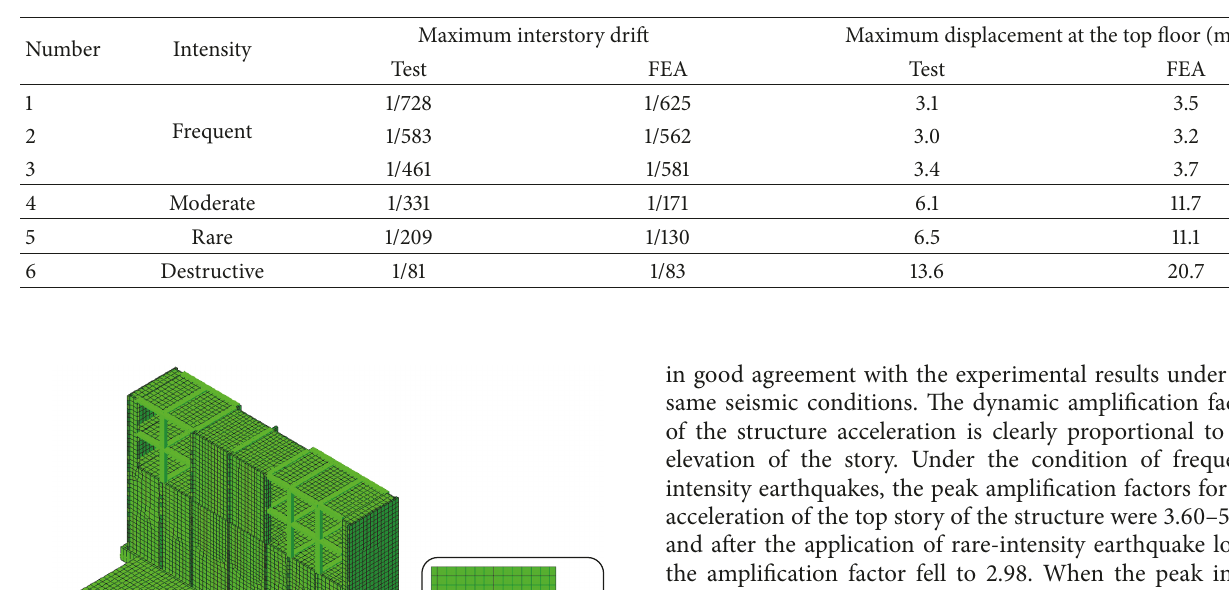
Table 5: Structure displacement under seismic loads.